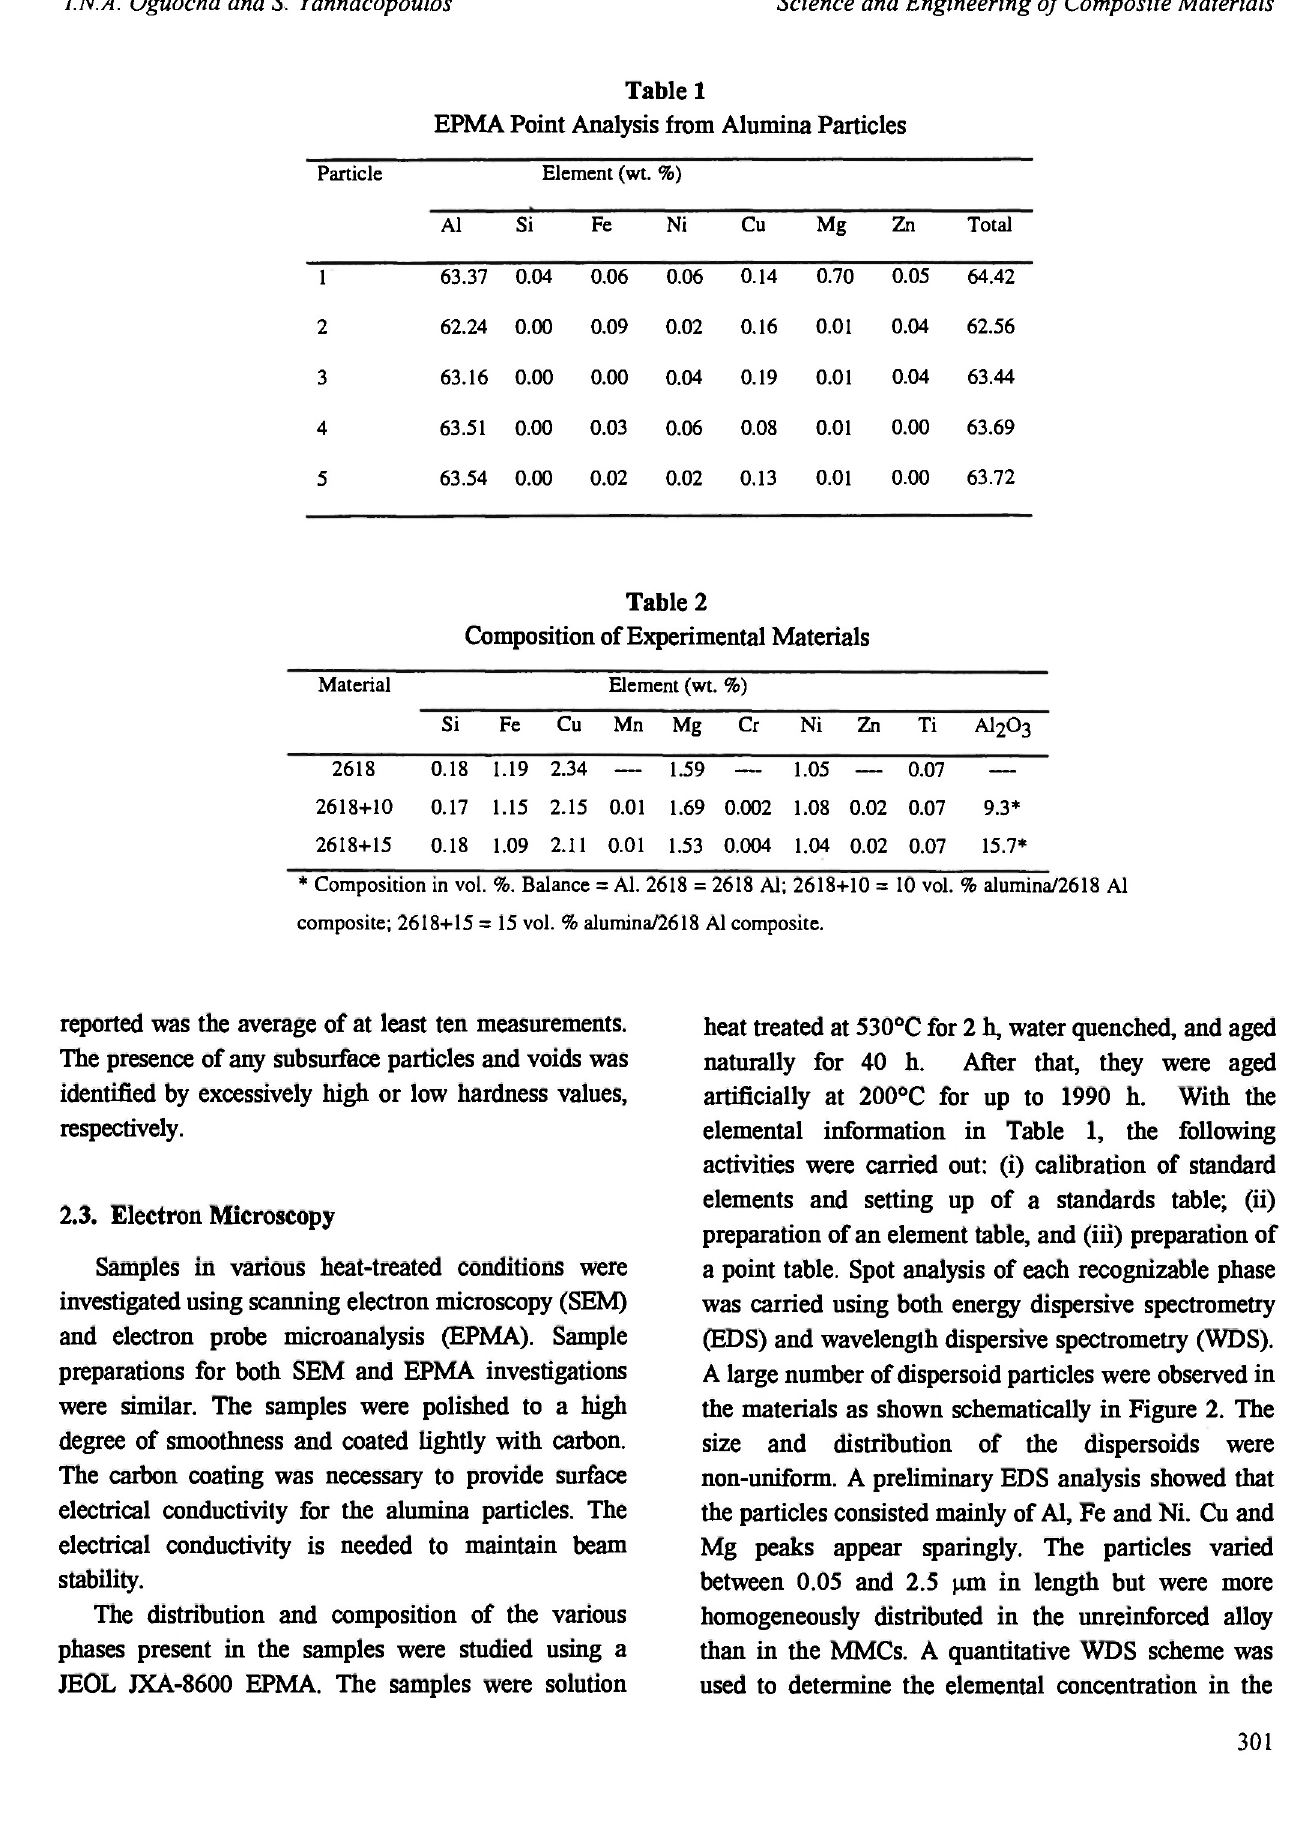
ΕΡΜΑ Point Analysis from Alumina Particles